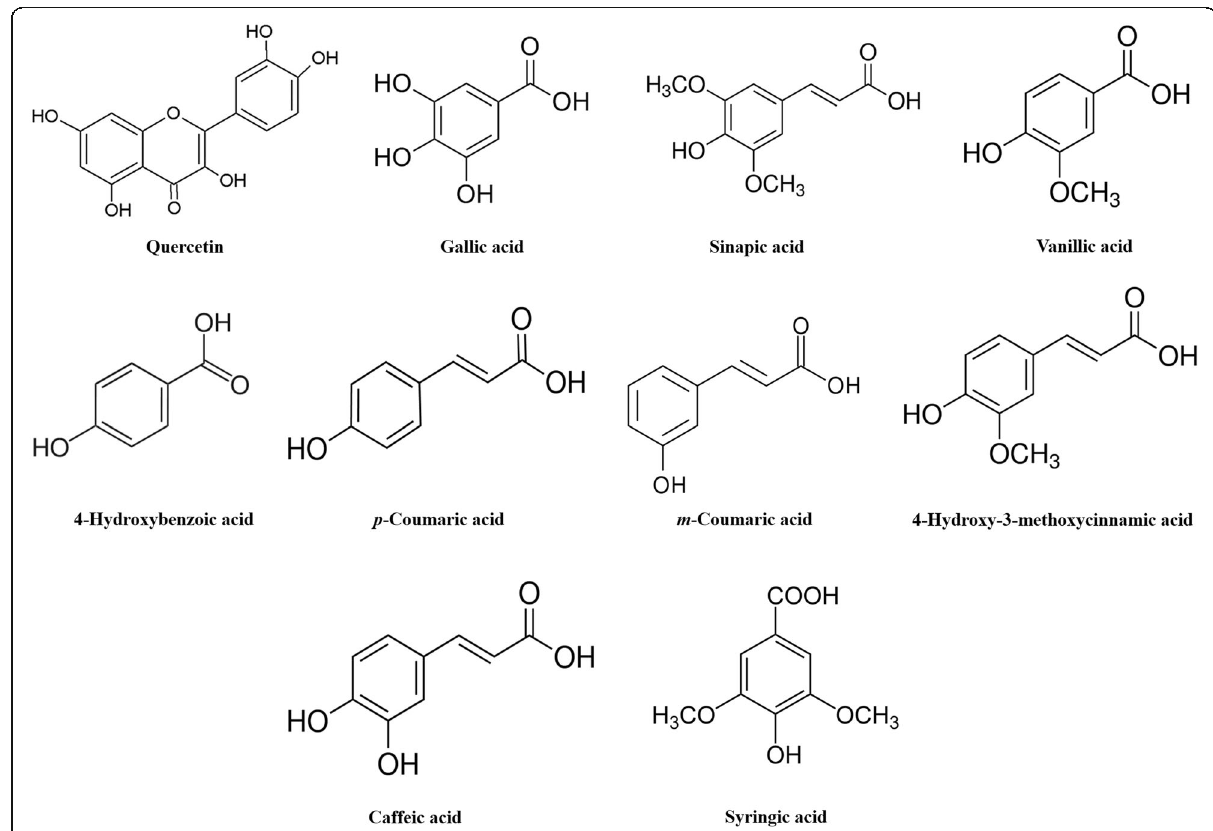
Fig. 2 Chemical structure of phenolic acids detected through reversed-phase high-performance chromatography (RP-HPLC) from solvent fractions of Moringa olerifera